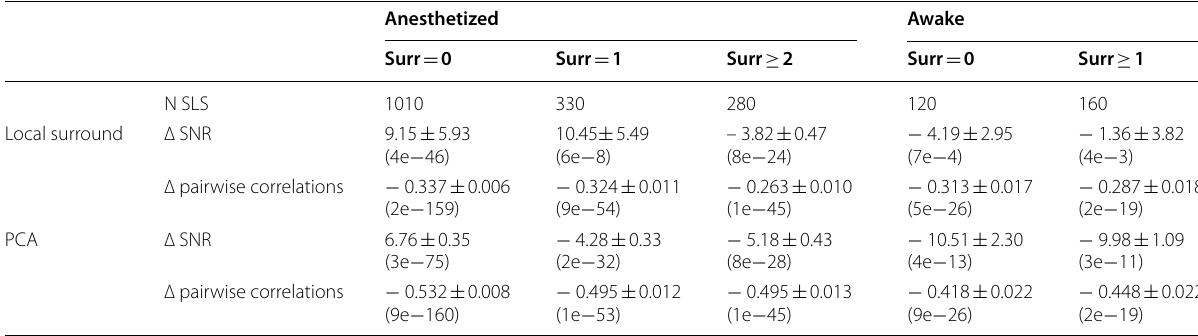
Table 5 Local neuropil